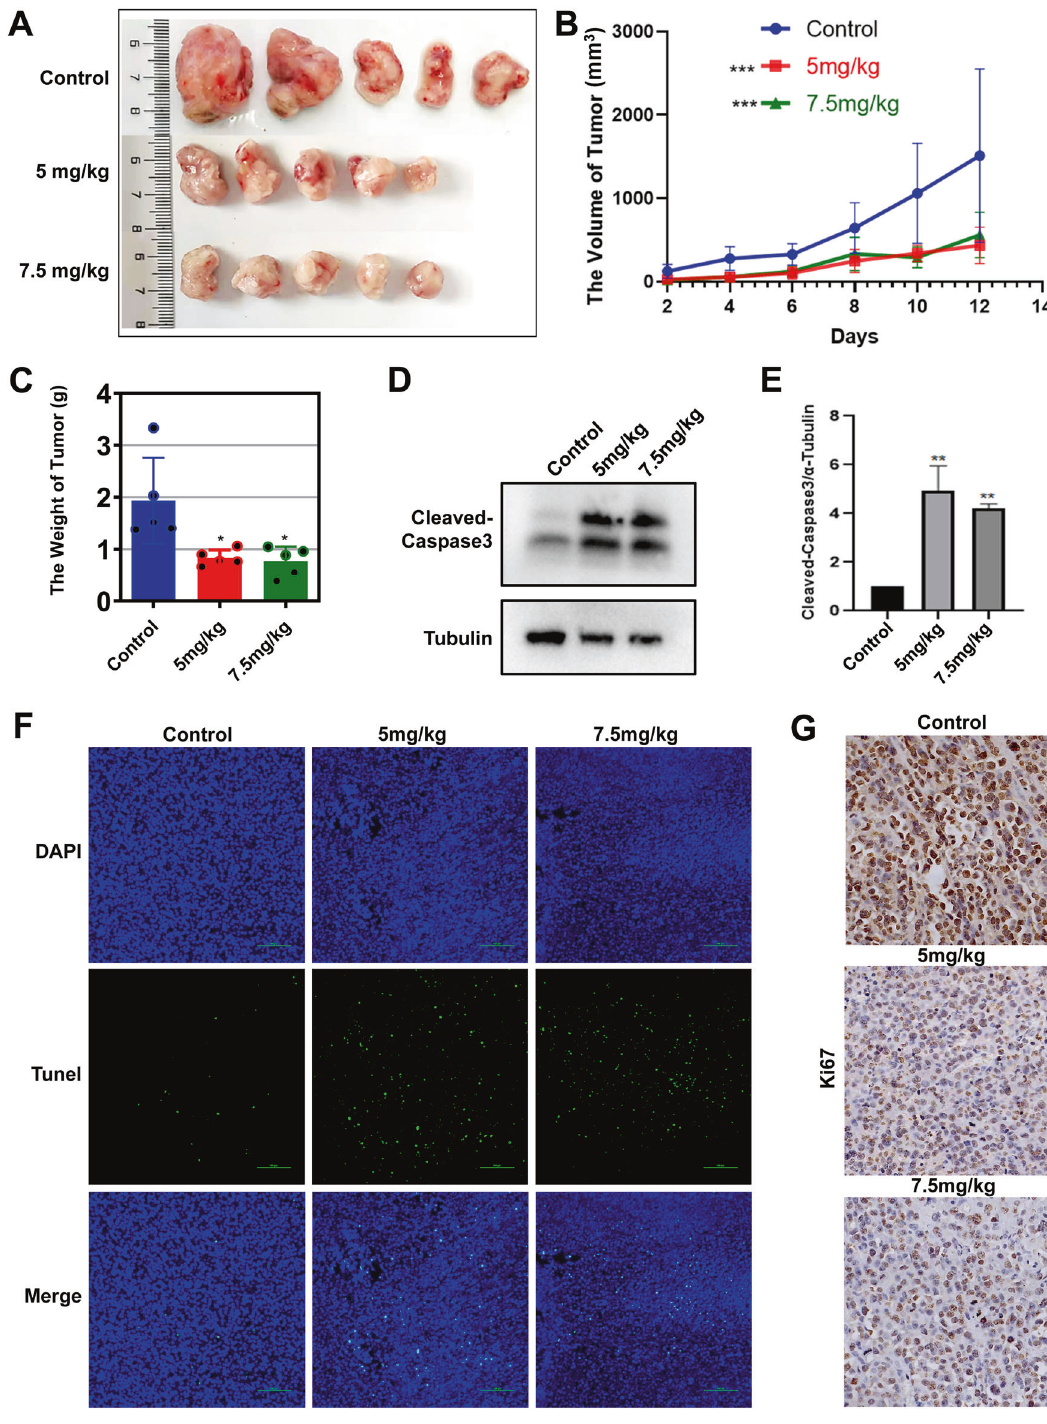
Fig. 3 TS inhibited tumor growth of H22 tumor bearing mice in vivo. A The image of tumor from H22 tumor bearing mice. B Tumor weight of H22 tumor bearing mice. C Tumor volume changes of H22 tumor bearing mice. D The expression of cleaved Caspase-3 after treated with TS by WB assay in vivo. E The statistical analysis for the WB assay in D . F The apoptotic cells in tumor tissue after treatment by TUNEL. G Ki-67 immunohistochemistry of the tumor sections in H22 tumor bearing mice (40×). Results are from independent duplicate or triplicate experiments and presented as means ± SD. Number of mice per group are seven ( n = 5). * p < 0.05 vs. the Control group; ** p < 0.01 vs. the Control group; *** p < 0.001 vs. the Control group. demonstrated therapeutic anti-tumor activity in different cancer of tumor and improving the anti-tumor immunity of tumor cell models. It was showed that as TRE potently inhibited bearing mice. proliferation and migration and expedited apoptosis in gastric Cancer progression is known to involve the degree of carcinoma cells [18]. Another study illustrated that TRE affected proliferation. Taraxacum of fi cinale root extract (TRE) has